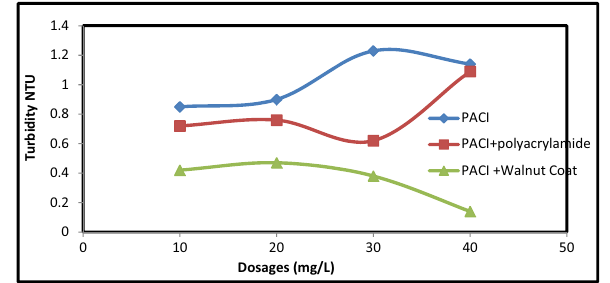
Figure 22: The relation between a coagulant aid and fi nal turbidity for water sample at 300 cm